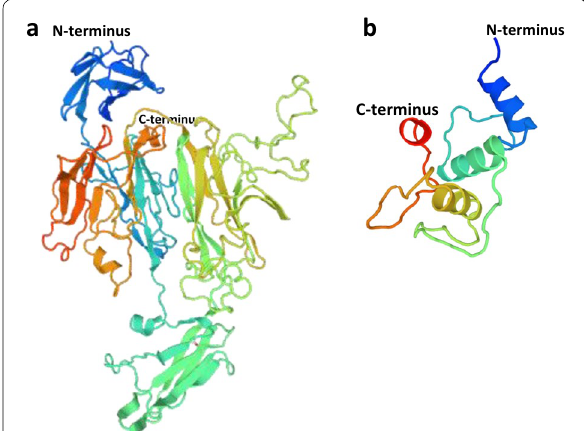
Fig. 6 Structural models of P. curdlanolyticus B-6 S1 protein. The unknown domain ( a ) and the surface layer homology (SLH1-2) domains ( b ) are shown. Homology models of P. curdlanolyticus B-6’s unknown and SLH1–2 domains based on template 4aq1.2 and 6cwc.1, respectively, were predicted using SWISS